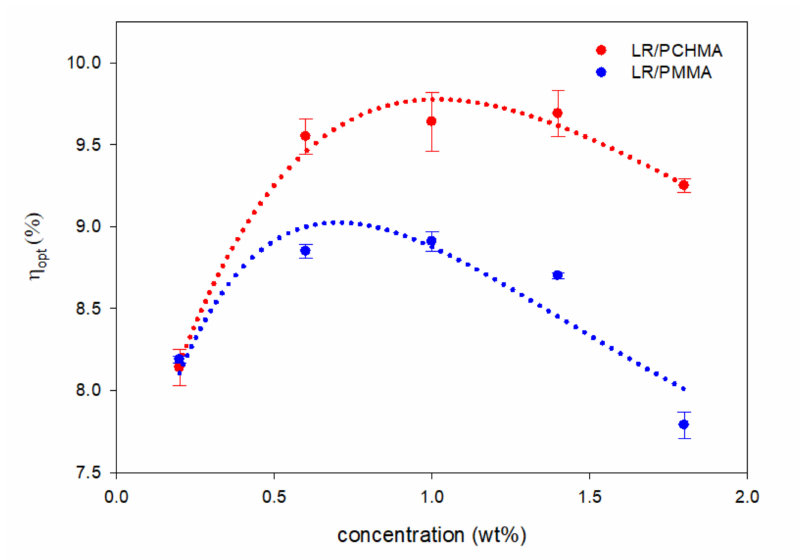
Figure 3. Optical e ffi ciency ( η opt ) % variation of LR / polymer thin films with di ff erent dye content (wt%), with a thickness of 23 ± 6 µ m and deposited on a 50 mm × 50 mm × 3 mm optically pure glass substrate. The curve was fitted with Equation (2) and the parameters are listed in Table 1. Error bars represent standard deviation in each η opt value ( n =